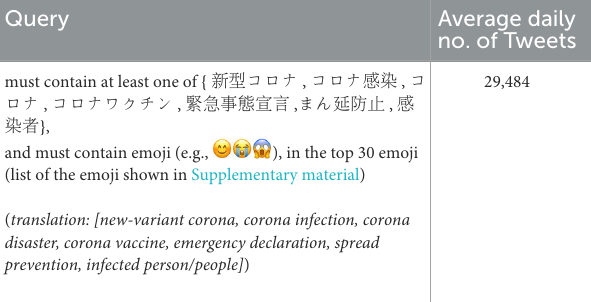
TABLE 1 Tweet data collection